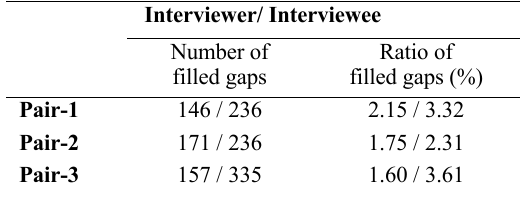
Table 3. The number and ratio of the filled gaps for each partici- pant’s raw gaze data.